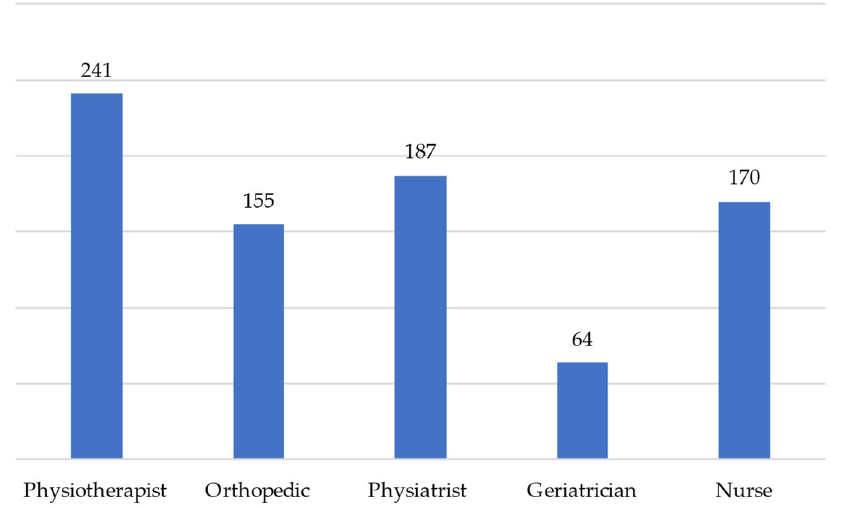
Figure 3. Absolute frequency of answers relating to the composition of the multidisciplinary team. Table 3. Answers referred to item 14: How much do you think the multidisciplinary team can positively affect the patient’s